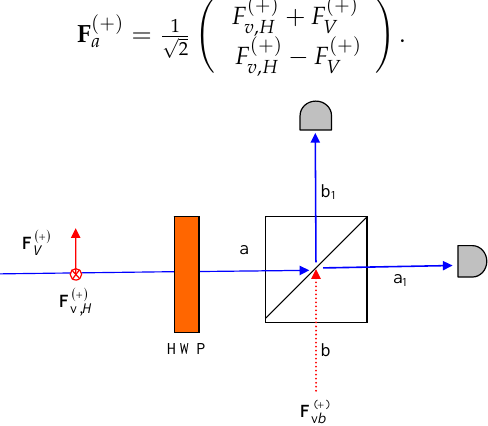
Figure 3. Measurement of the polarisation in the diagonal basis. A vertically polarised signal must be accompanied by the horizontal component of the ZPF. The intensities corresponding to the horizontal and vertical components of the light beam leaving the HWP give rise to anticorrelation in channels a 1 and b 1